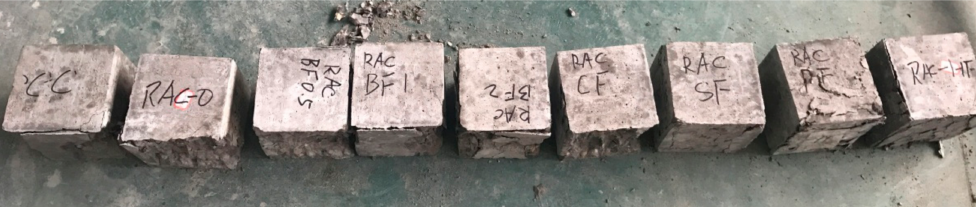
Figure 5. Failure modes of cube compressive specimens.